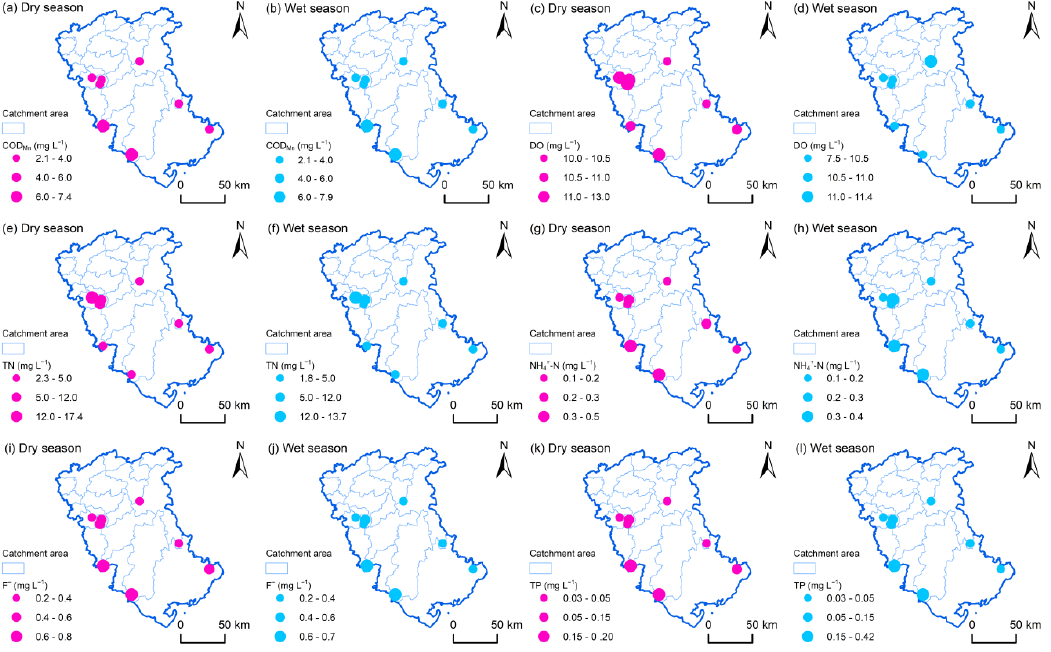
Figure 3. The spatial variation of COD Mn ( a , b ), DO ( c , d ), TN ( e , f ), NH + 4 -N ( g , h ), F − ( i , j ) and TP ( k , l ) during the two seasons.